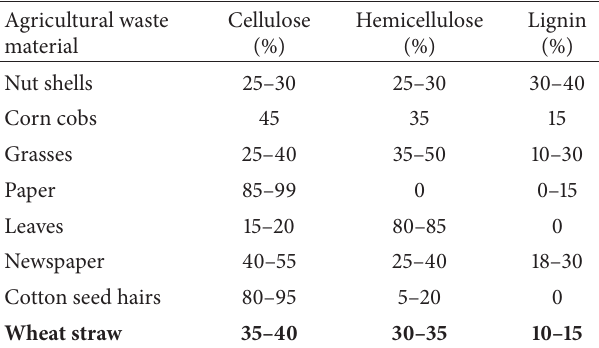
Table 1: The cellulose, hemicellulose, and lignin content of various agricultural waste materials.